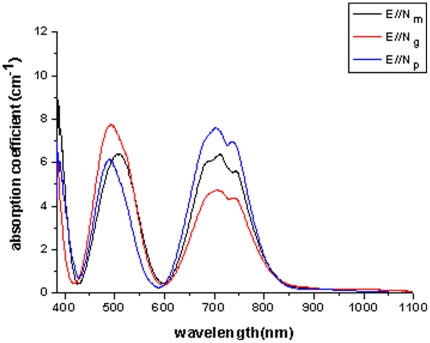
Polarized absorption spectrum of Cr3+∶MgMoO4 crystal at room temperature.